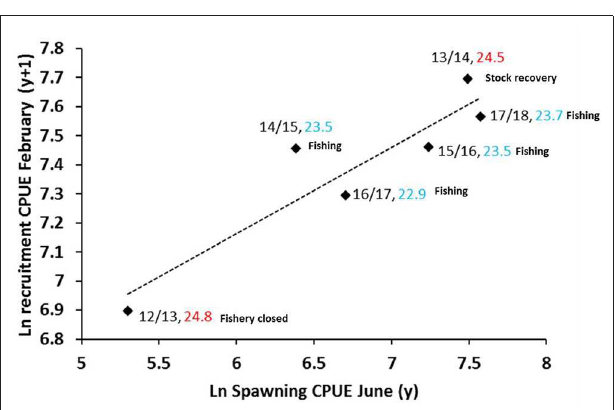
FIGURE 9 | Preliminary stock-recruitment relationship for the Shark Bay crab stock based on peak spawning (all females ≥ 110mm CW) biomass during the June survey (t) and peak recruitment (females < 110mm, males < 105mm CW) biomass during the following February survey (y + 1). Labels refer to year of spawning/year of recruitment, mean summer SST (Dec–Jan) (y/y + 1) ≥ 24 ◦ C in red and < 24 ◦ C in blue and fishery